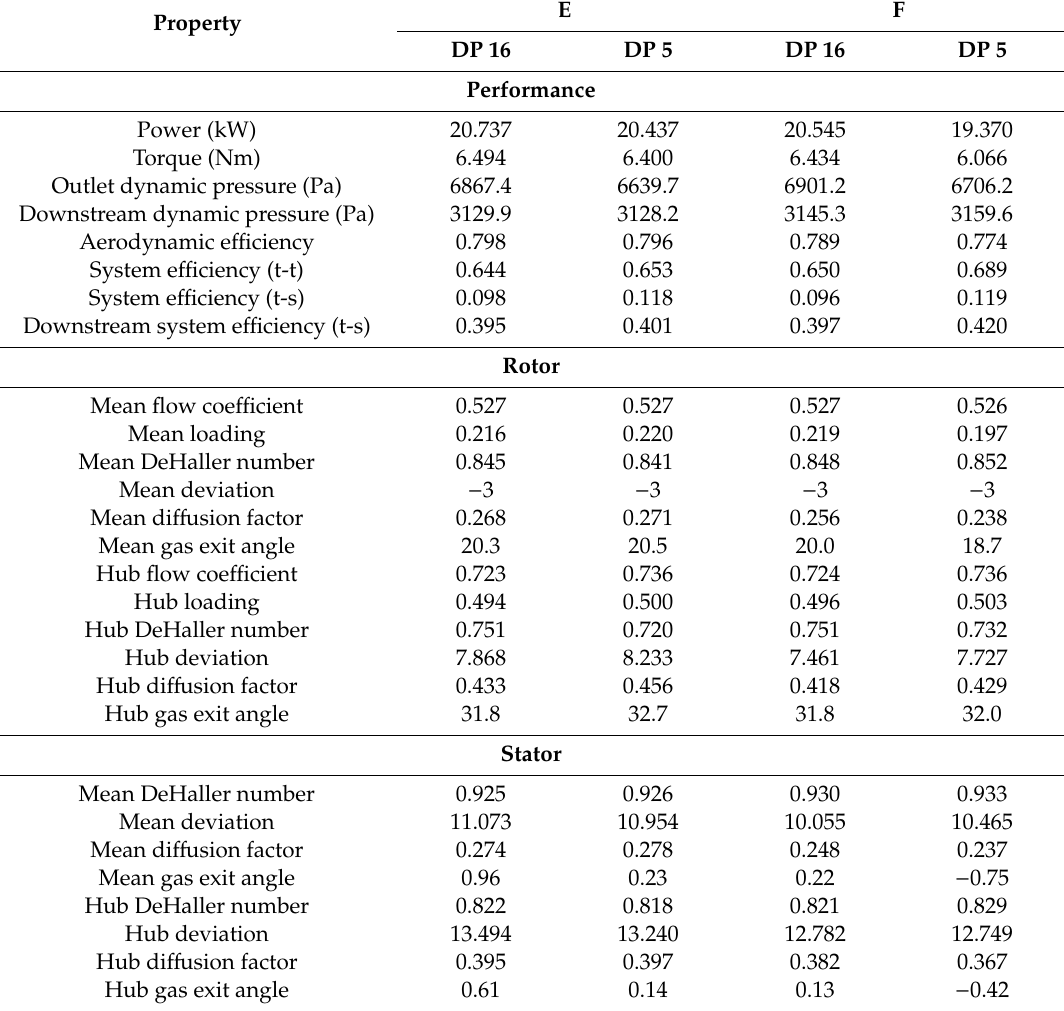
Table 12. Numerical results of the chosen design points from the through-flow calculation.